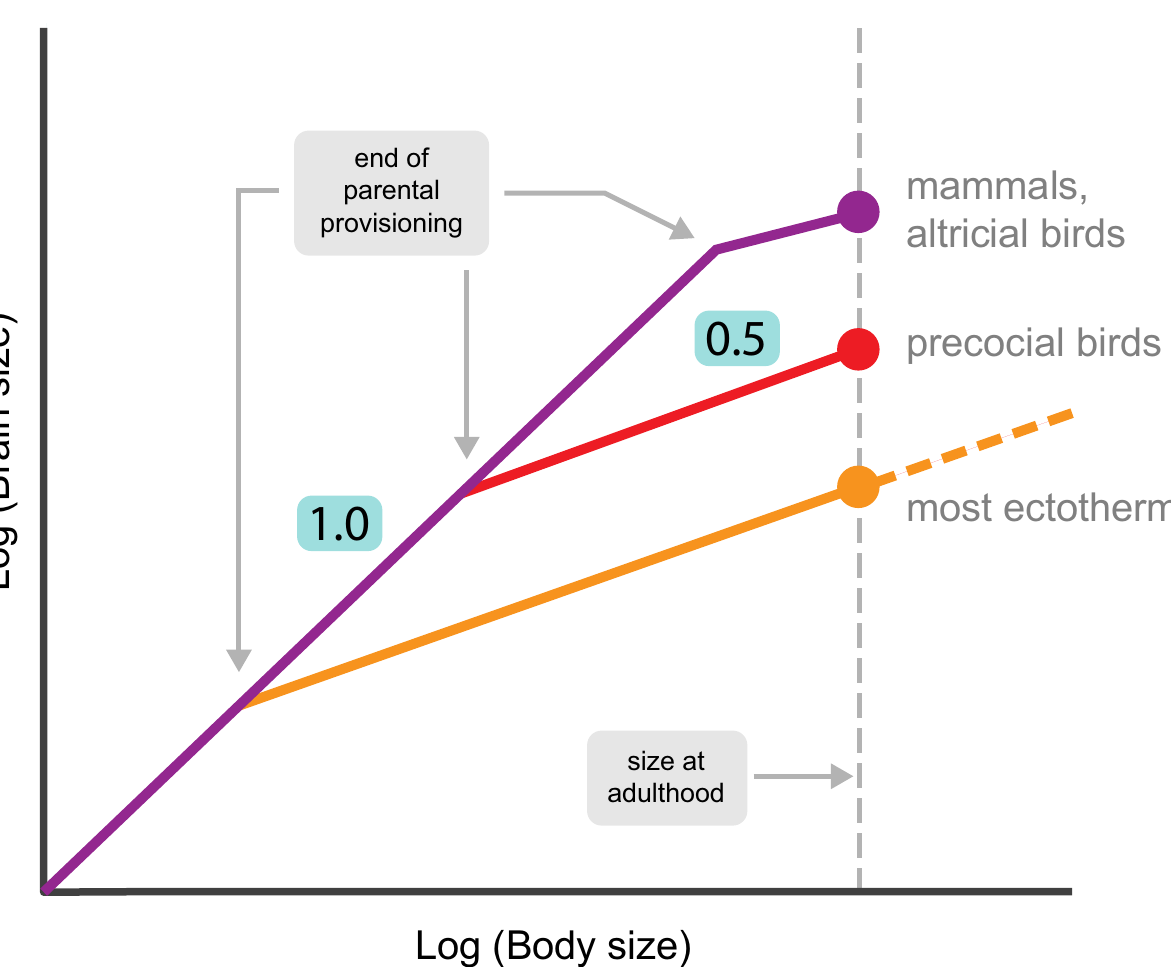
Fig 4. Schematic depiction of brain growth relative to body growth in different vertebrates as a function of parental provisioning. The first phase (parental provisioning) shows the same, steep slope (virtually isometric: 1.0). After the end of parental provisioning, the slope becomes very low (ca 0.2) in mammals and altricial birds, whereas it become intermediate in precocial birds and ectotherms (ca 0.5) until adulthood is reached, and in most of the latter continues at the same relative rate after that due to indeterminate growth (sources are provided in the main text).